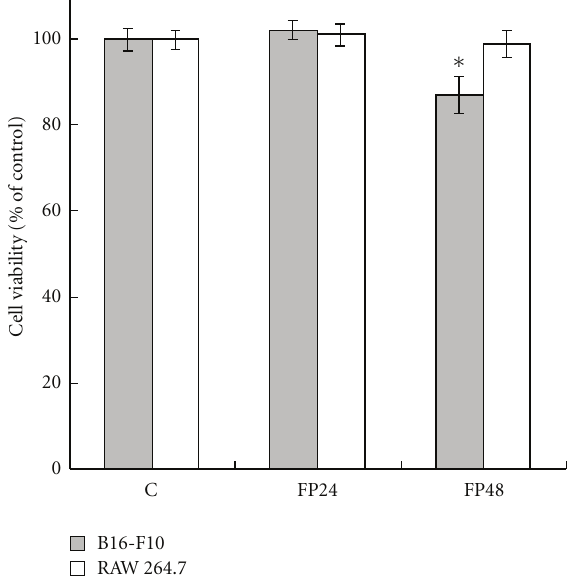
Figure 2: The e ff ect of cFIR on B16-F10 and RAW 264.7 cell viability. Groups C, FP 24, and FP48 received cFIR treatment for 0, 24, and 48h, respectively. Values are expressed as the mean and standard deviation, and the di ff erence between groups was tested using the Wilcoxon